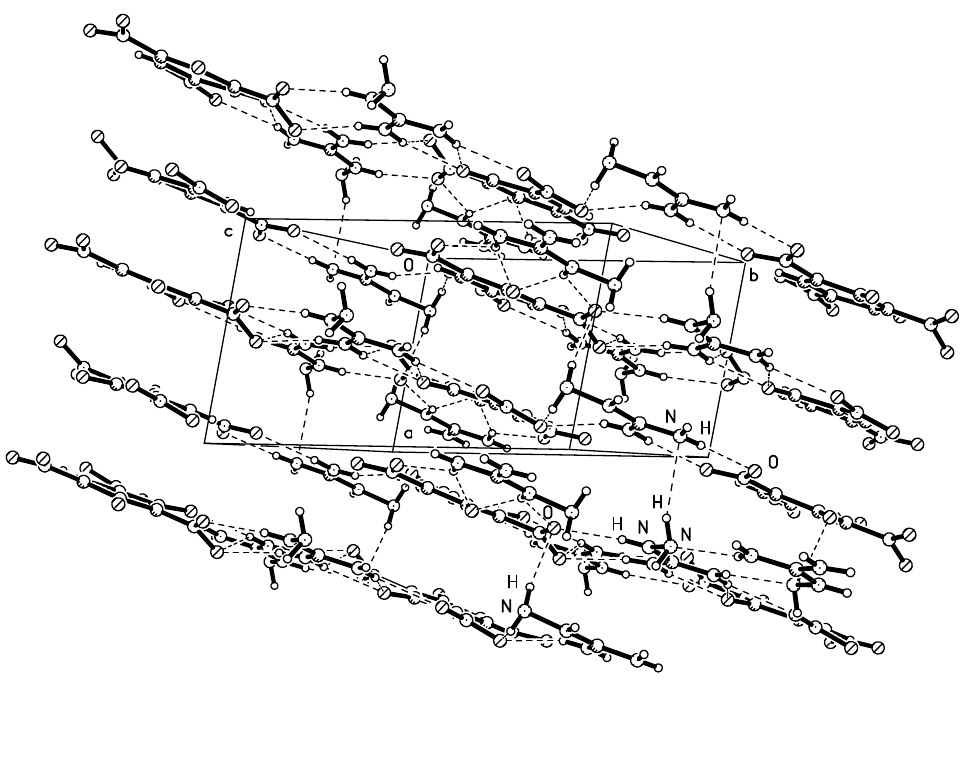
Figure 3. Crystal packing of the title compound aminoguanidinium